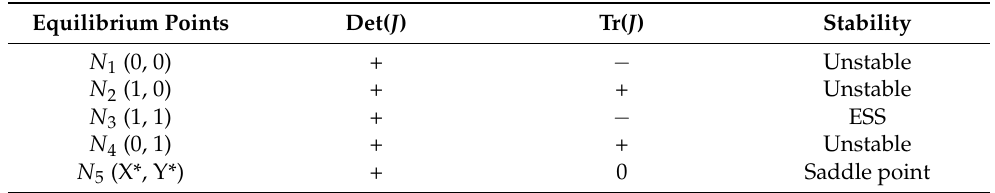
Table 5. Equilibrium points of determinants and traces (with the supervision of the central govern-